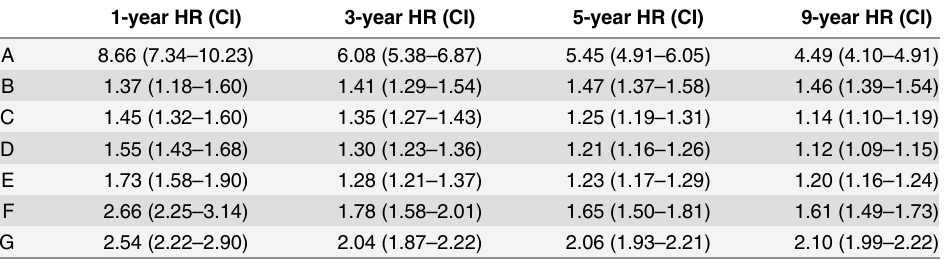
Table 5. Risk of death by trajectory. Model adjusted for age, race, gender, for age, race, gender, diabetes mellitus, hypertension, cardiovascular disease, hyperlipidemia, peripheral artery disease, cerebrovascular disease, chronic lung disease, hepatitis C, HIV, dementia, and eGFR at time of cohort entry (T0). Reference group is patients with stable kidney function before cohort entry